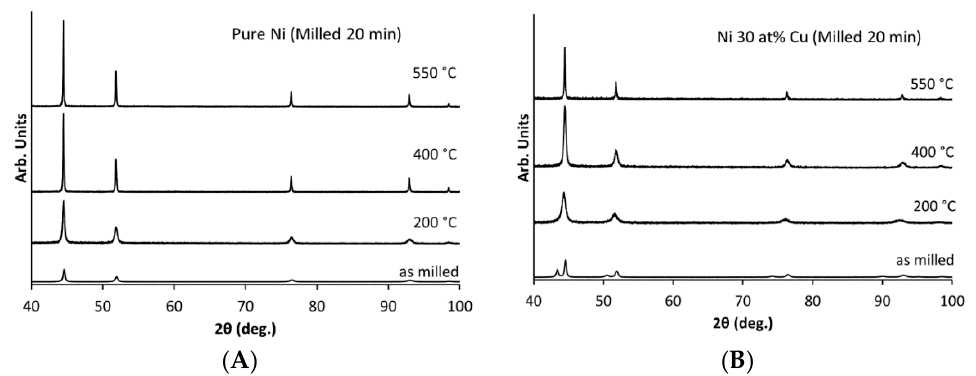
Figure 7. XRD patterns collected from ( A ) Ni and ( B ) Ni 30 at % Cu after milling for 20 min and annealing at the listed temperatures for 1 h in 5% H 2 (bal. Ar).